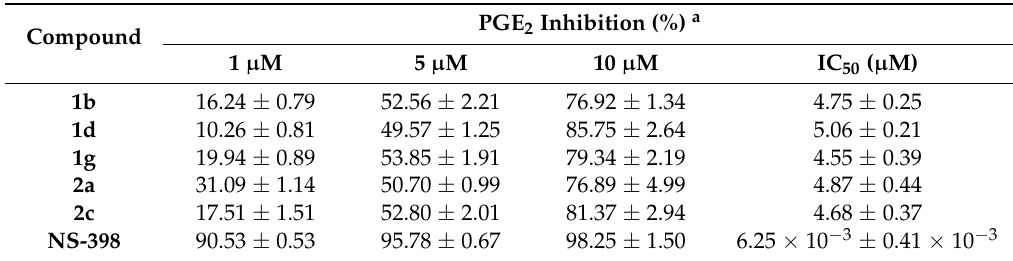
Table 4. Inhibitory effect and IC 50 values of compounds 1b , 1d , 1g , 2a , and 2c on prostaglandin E2 (PGE 2 ) production.